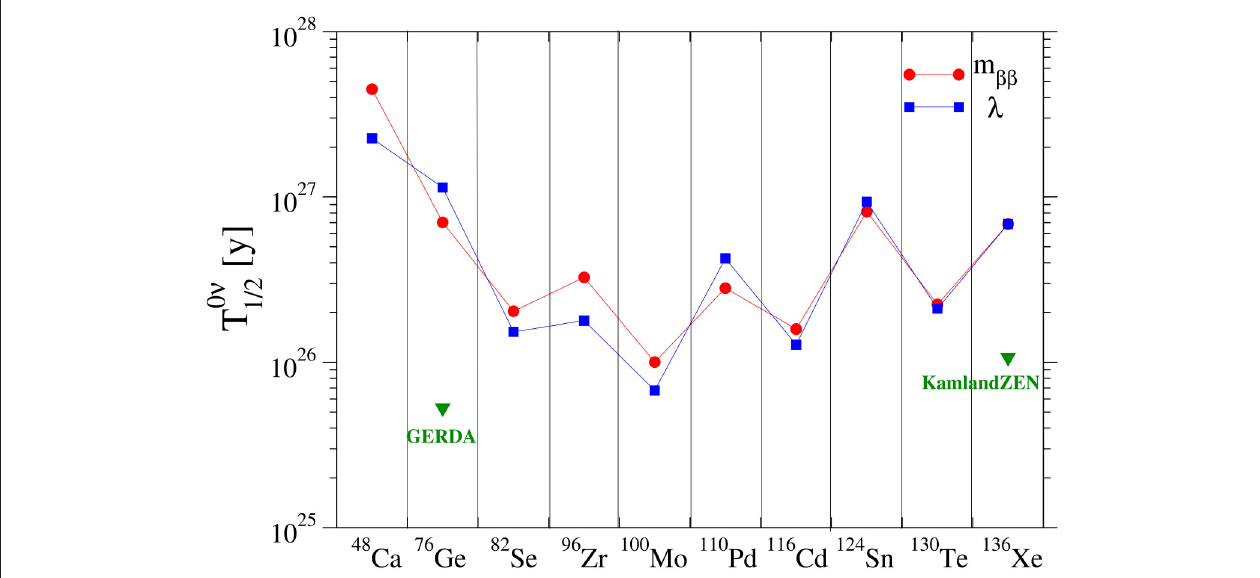
FIGURE 4 | The 0 νββ -decay half-lives of nuclei of experimental interest calculated for m ββ (red circle) and λ (blue square) mechanisms by assuming an illustrative case of observation 0 νββ -decay of 136 Xe with half-life T 0 ν 1 / 2 half-life of 76 Ge (the GERDA experiment) and 136 Xe (the Kamland-Zen experiment) are displayed with green